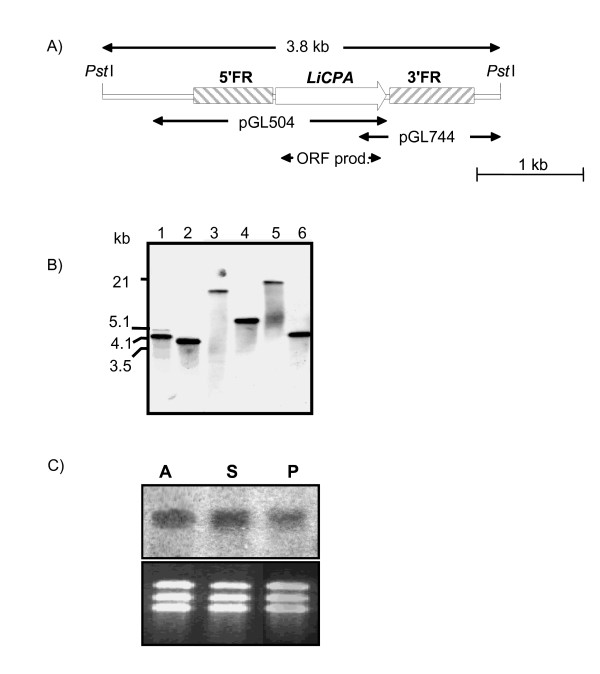
LiCPA genomic organisation and expression. A) Map of LiCPA locus with the different subclones analysed indicated. B) Southern blot of L. infantum JPCM5 gDNA hybridized with the LiCPA PCR product. The gDNA was digested using SphI (lane 1), PstI (lane 2), XhoI (lane 3), SmaI (lane 4), SacI (lane 5) and ApaI (lane 6). C) Northern blot of total RNAs from L.infantum JPCM5 log phase promastigotes (P), stationary phase promastigotes (S) and axenic amastigotes (A) hybridized with the LiCPA ORF PCR product. After washing, the membrane was exposed on a phosphor-activated screen. An ethidium bromide-stained gel of RNA samples for each life cycle stage is shown in the lower panel.